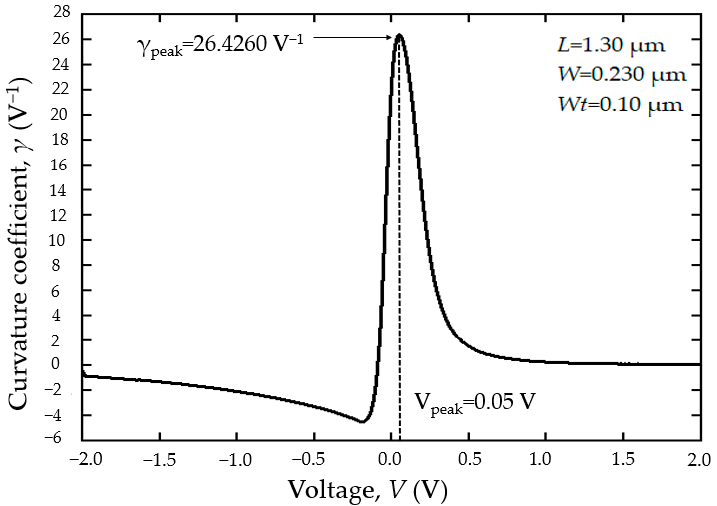
Figure 10. The curvature coefficient, γ , of the optimized SSD structure.